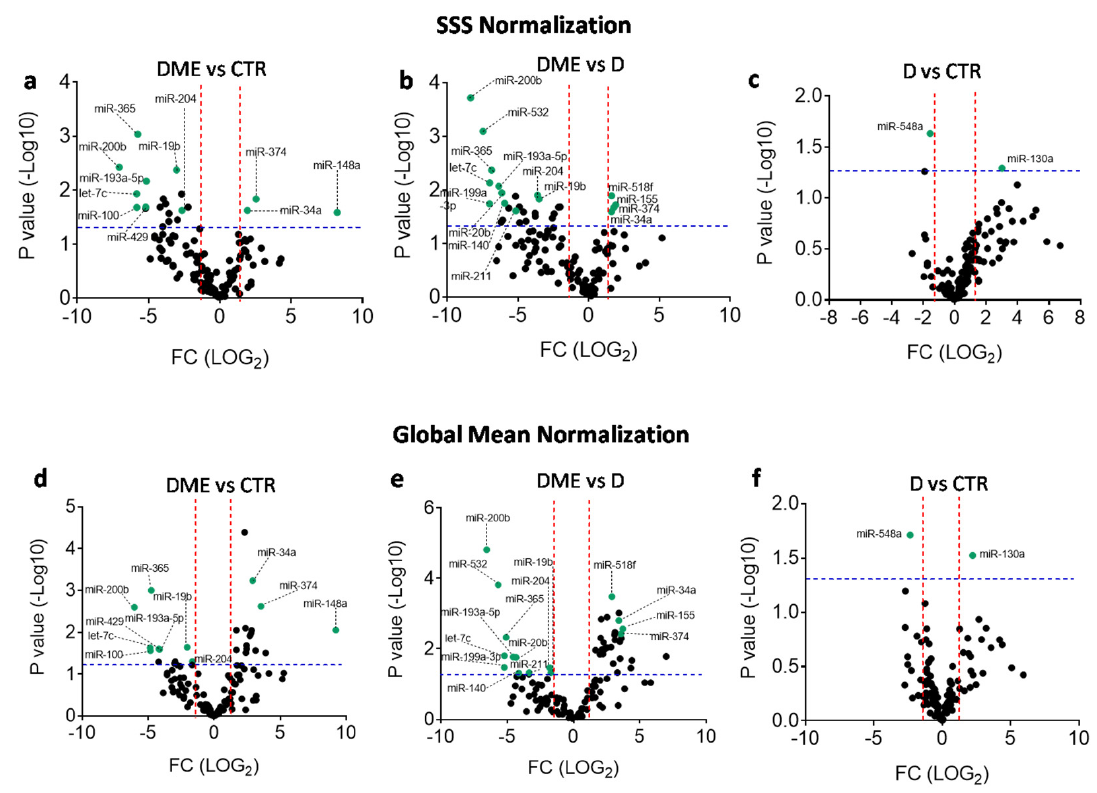
Figure 2. Volcano plots showing differentially expressed miRNAs according to two different normalization strategies. ( a – c ) Volcano plots of differentially expressed miRNAs in DME vs CTR ( a ), DME vs. D ( b ), and D vs. CTR patient groups ( c ) computed using SSS normalization strategy. ( d – f ) Volcano plots of differentially expressed miRNAs in DME vs. CTR ( d ), DME vs. D ( e ), and D vs. CTR patient groups ( f ) computed using Global Mean normalization strategy. Differentially expressed miRNAs found for both normalizations are labeled and indicated as green dots. Fold change cutoff (red lines) was set at 2.5-fold while p -values cutoff (blue line) was set at 0.05 based on Student’s t test on normally distributed Δ CT.